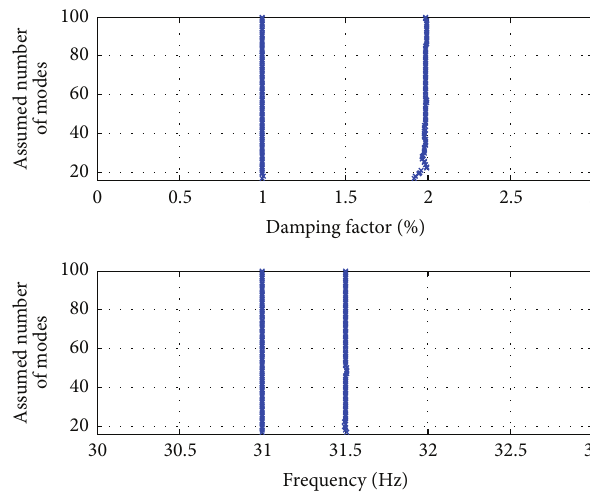
Figure 4: Stabilization diagram on eigenfrequencies and damping factorsforthetwo-DOFsystemusingshiftingpropertiesoftheblock observability